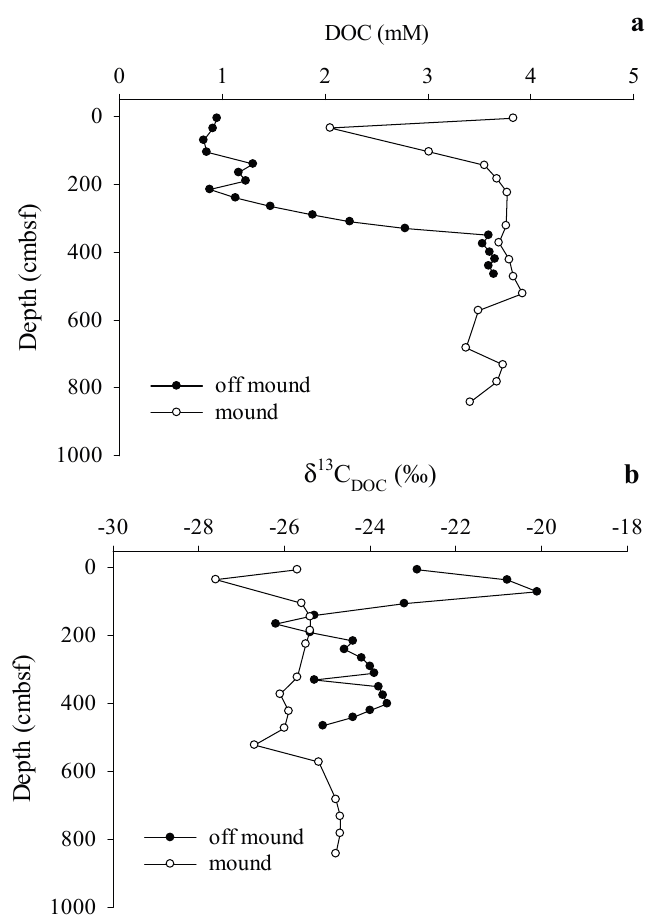
Figure 7. ( a ) Vertical profiles of sediment pore water dissolved organic carbon (DOC) concentrations compared on-mound and off-mound; and ( b ) Vertical profiles of δ 13 C DOC values measured on-mound and